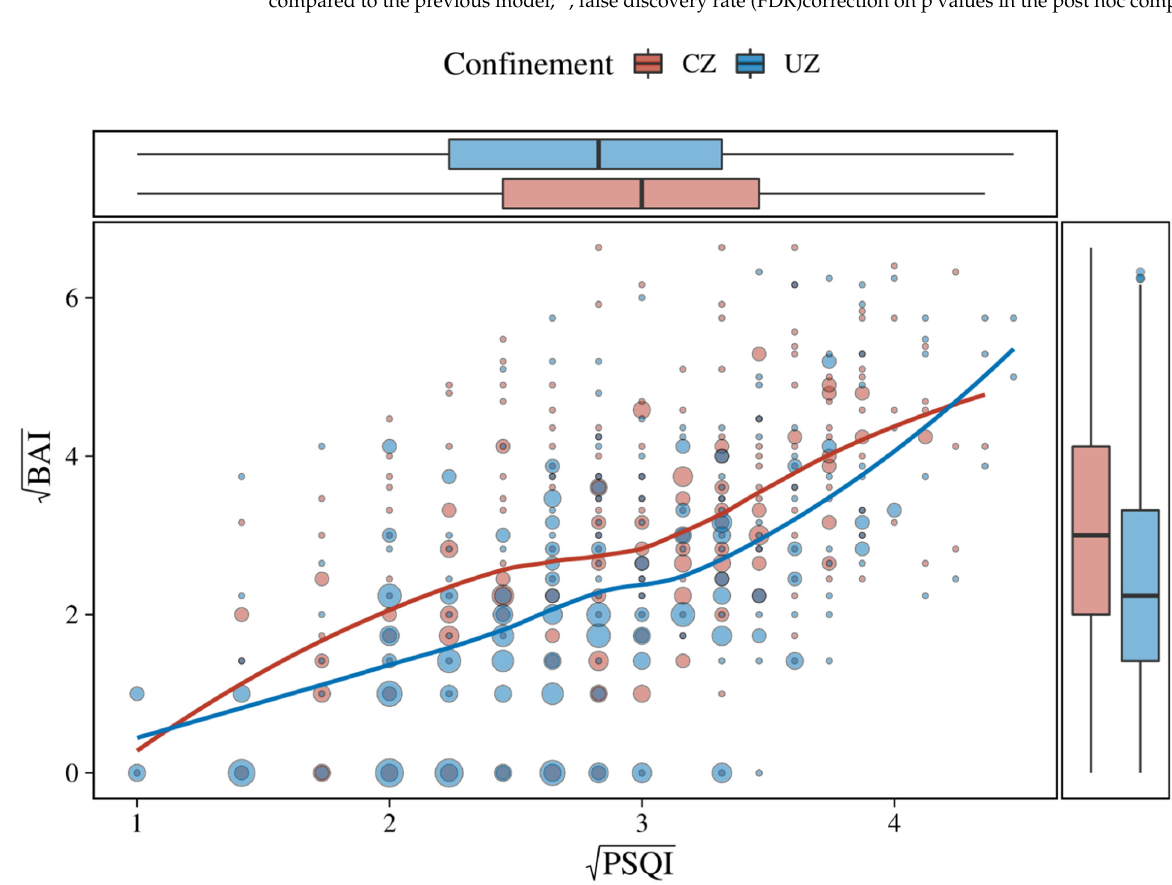
Figure 1. Scatter plot of (cid:3493)𝑃𝑆𝑄𝐼 and √𝐵𝐴𝐼 with superimposed weighted local regression lines (LOESS); box plots indicate the distributions of these scores for the CZ and PZ groups. The size of the points represents the number of observations at each point.